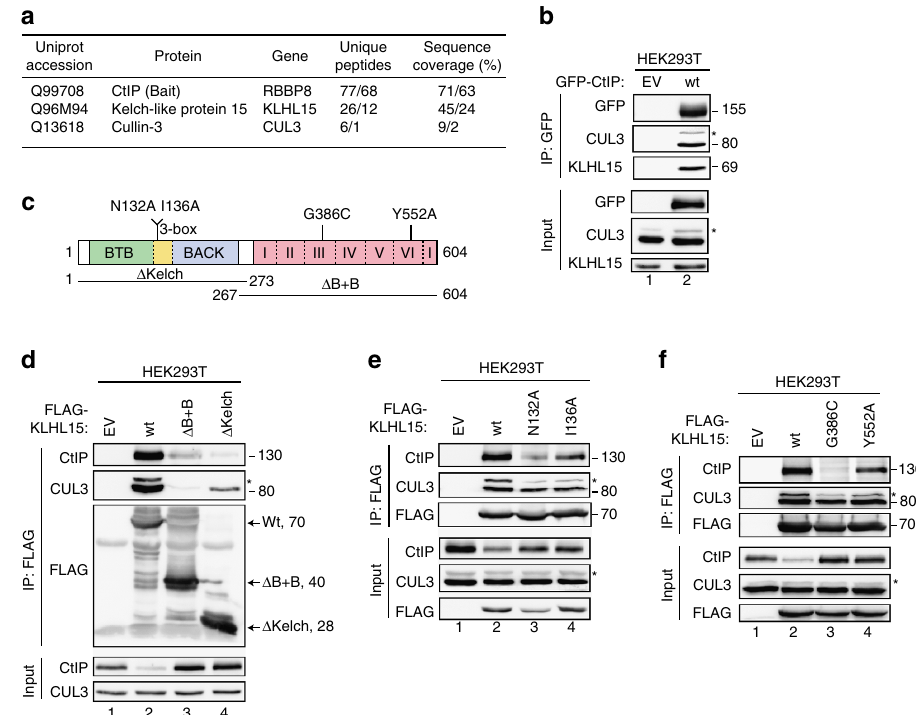
Figure 1 | CtIP interacts with the CUL3-KLHL15 complex. ( a ) HEK293 cells inducibly expressing StrepHA-tagged CtIP were used for tandem affinity purification of protein complexes. The number of unique peptides and sequence coverage for the proteins identified by mass spectrometry are listed. ‘/’ delimitates the data from two biological replicates. ( b ) HEK293T cells were transfected with either empty vector (EV) or the GFP-CtIP expression constructs. Forty-eight hours after transfection, cells were lysed and whole-cell extracts were subjected to IP using anti-GFP affinity resin. Inputs and recovered protein complexes were analysed by immunoblotting. ( c ) Schematic representation of the human KLHL15 protein indicating truncation and single-amino acid point mutants thereof used in d – f . ‘3-box’ denotes CUL3-interacting box, whereas the six Kelch repeats are indicated in pink. ( d – f ) HEK293Tcells were transfected with either EV or the indicated FLAG-KLHL15 expression constructs. Forty-eight hours after transfection, cells were lysed and whole-cell extracts were subjected to IP using anti-FLAG M2 affinity resin. Inputs and recovered protein complexes were analysed by immunoblotting. Asterisks indicate neddylated